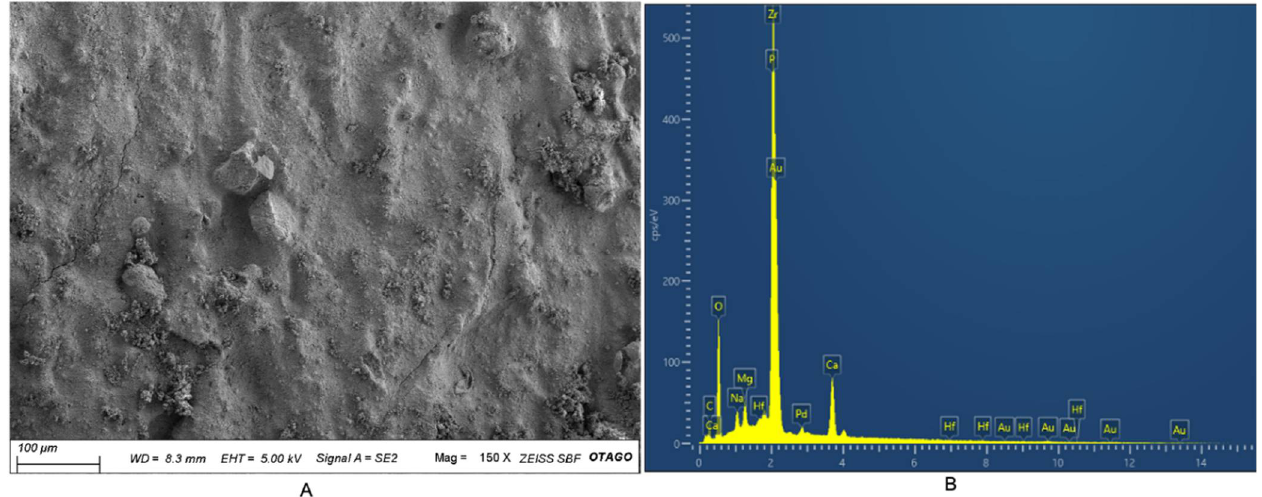
Figure 2. ( A ) SEM photomicrograph of the experimental pulp-capping material, scale bar = 100 μm. ( B ) EDX spectra of the hybrid biocomposite. Table 3. Composition of the experimental pulp-capping agent determined by SEM-EDX. Element Weight (%) C